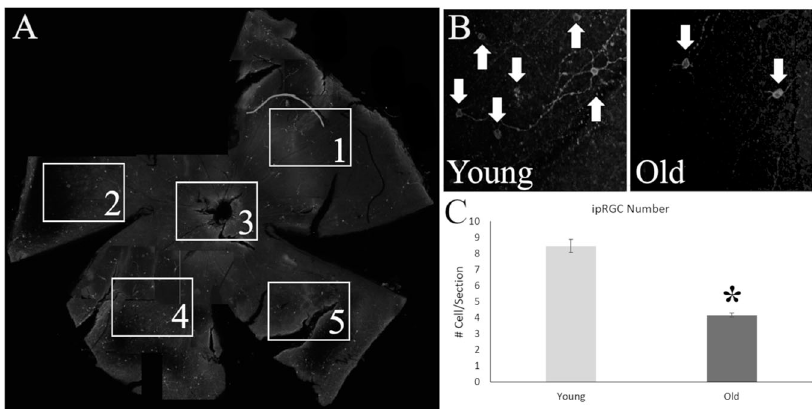
Fig. 5 Histological analysis of intrinsically photosensitive retinal ganglion cells (ipRGC) from the retinas of old and young mice stained for melanopsin. A Whole mount retinas of the mice were divided into four petals, one image for counting was taken for each petal and from a central location. B The number of total melanopsin positive cells (White Arrows) were lower in old mice (Right Panel) than in their younger counterparts (Left Panel). C Statistical analysis of the number of cells per section demonstrated a signi fi cant difference between the age groups, with a 50% reduction in number of cells in older mice. * p <